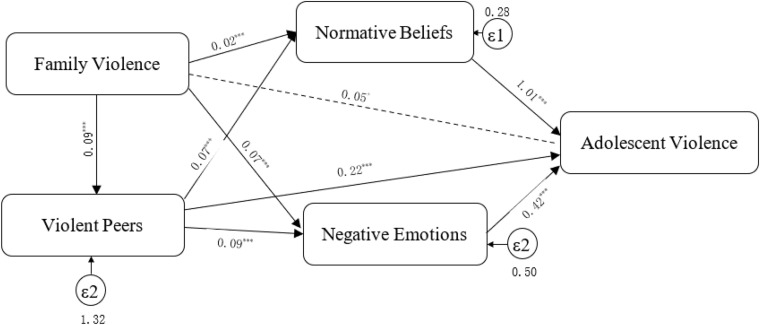
Mediation model.